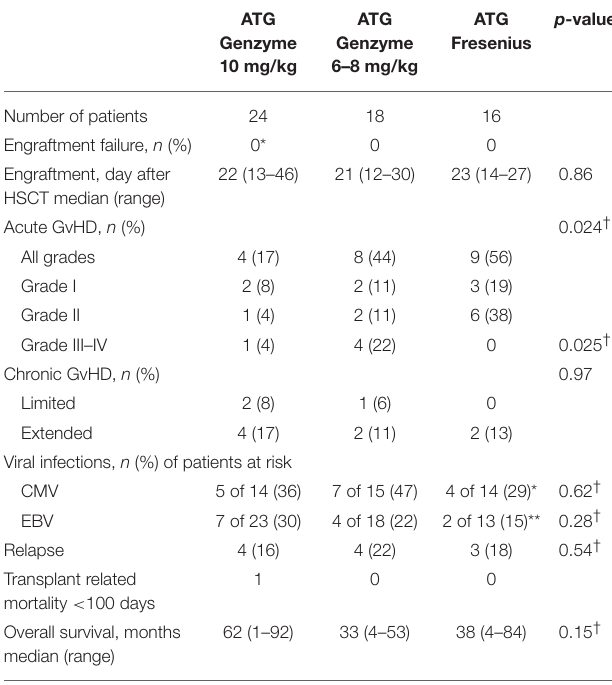
TABLE 2 | Clinical outcome parameters in the ATG-Genzyme-high, ATG-Genzyme-low, and ATG-Fresenius